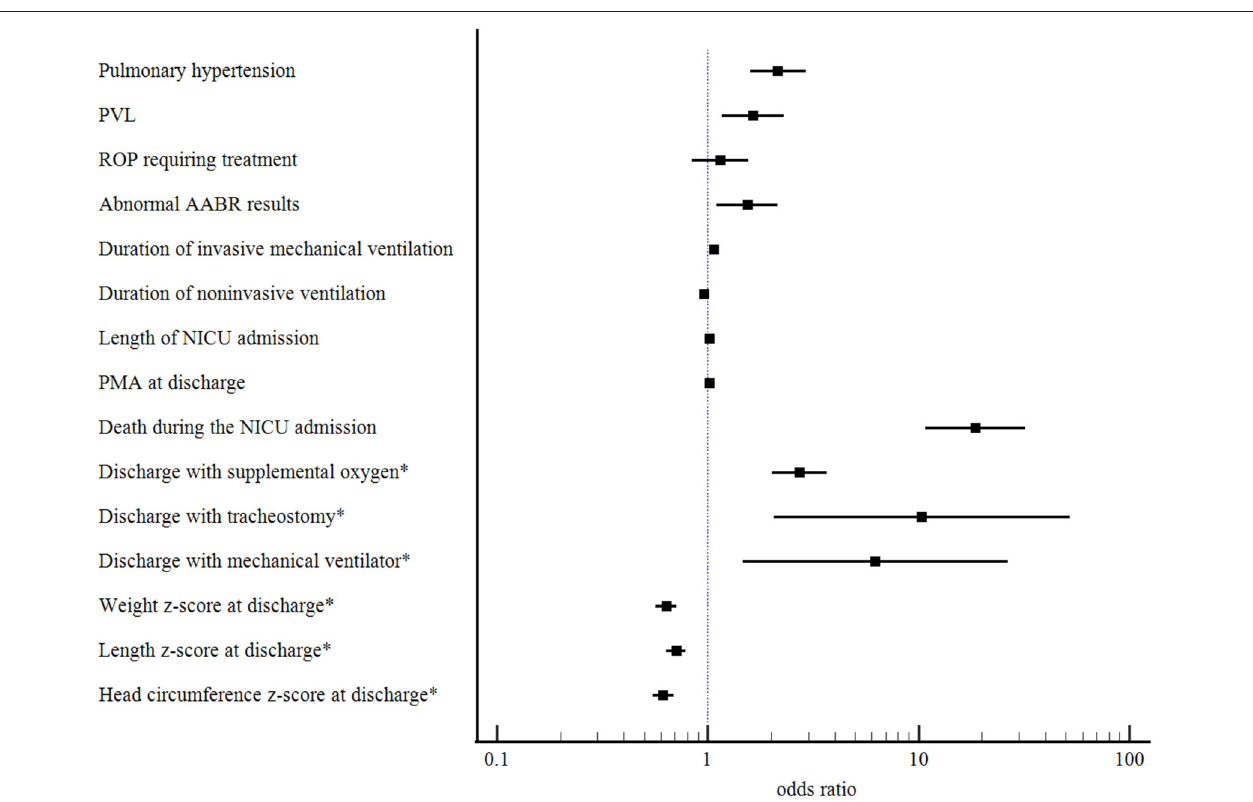
FIGURE 2 | Adjusted odds ratios with their 95% confidence intervals for comorbidities and clinical burden of the type 2 severe BPD compared to those of the type 1 severe BPD. BPD, bronchopulmonary dysplasia; PVL, periventricular leukomalacia; ROP, retinopathy of pre-maturity; AABR, automated auditory brainstem response; NICU, neonatal intensive care unit; PMA, post-menstrual age. *Calculated for survivors to NICU